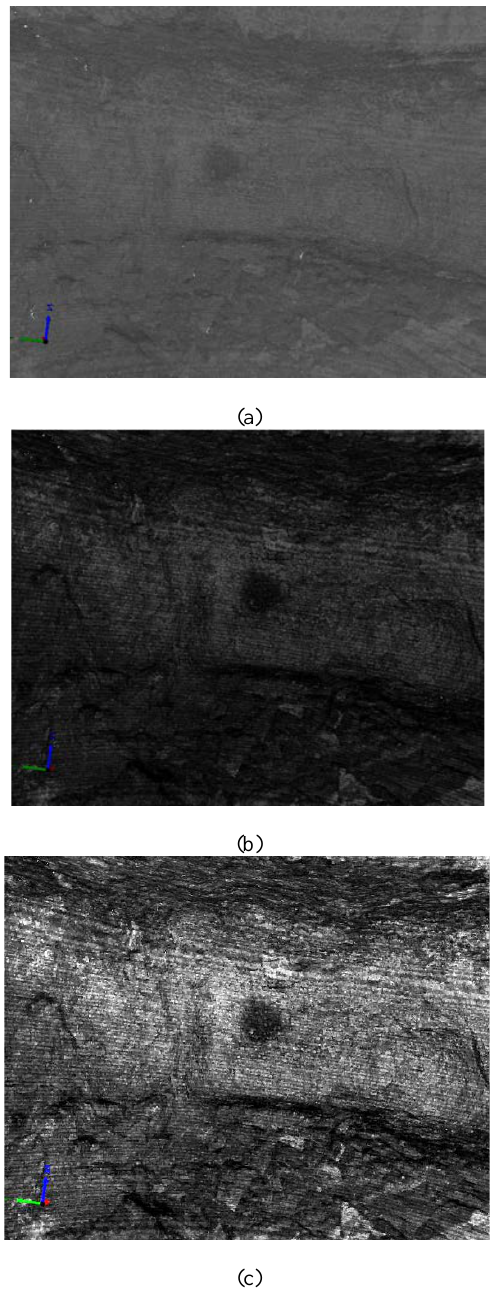
Figure 9. Detail from Remigia Cave: a) Initial intensity values; b) Corrected intensity values; c) Corrected intensity image with histogram